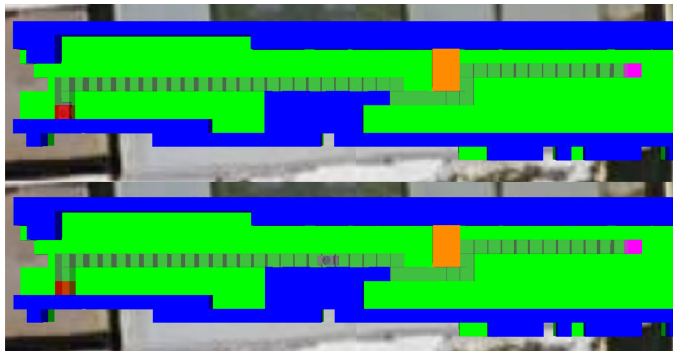
Figure 7. Path Planning Experiment 2, the experiment of STA* algorithm. Blue indicates wall, red indicates starting point, purple indicates the end point, green indicates passable area, grey indicates the path.